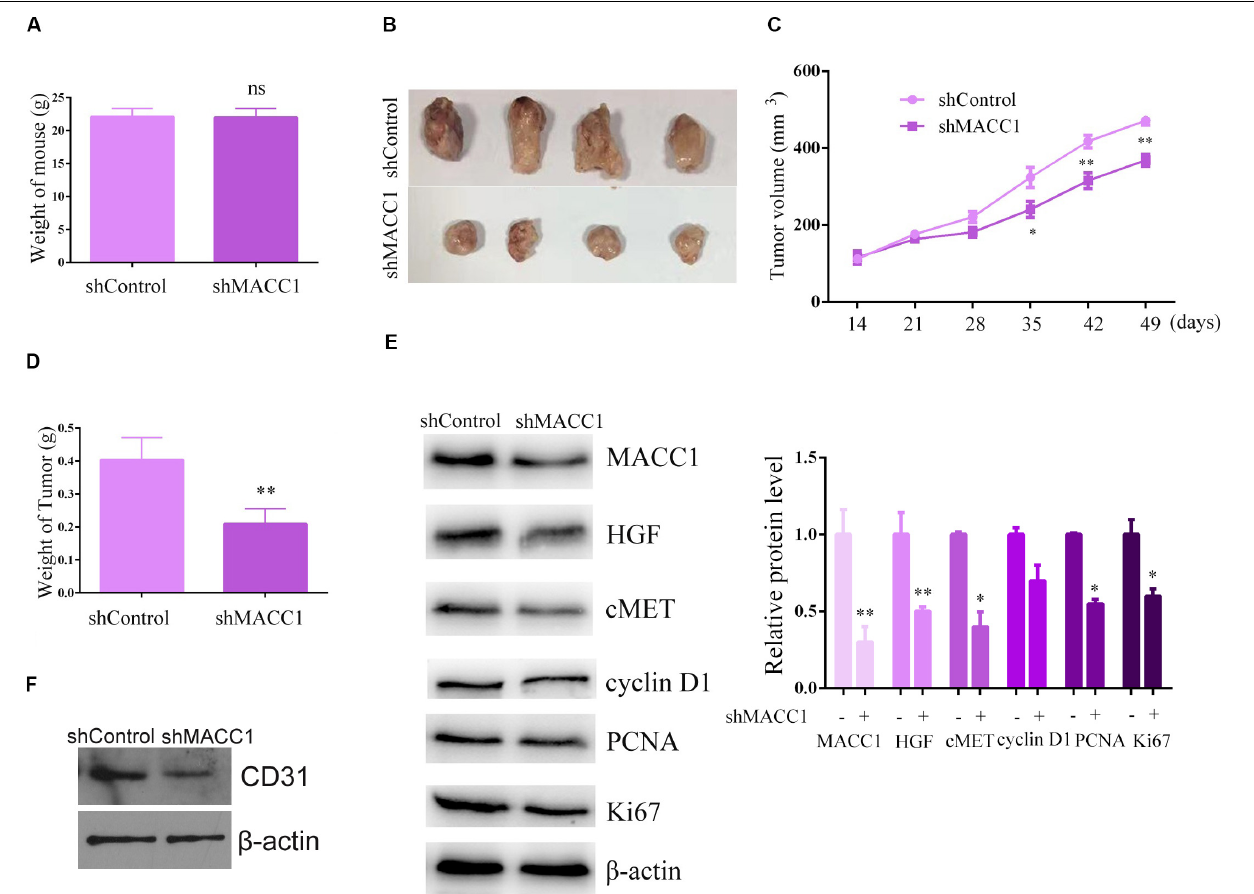
FIGURE 5 | MACC1 depletion inhibits osteosarcoma (OS) cell xenograft tumor growth in mice. U-2OS cells infected with control or MACC1 shRNA lentiviral vectors were subcutaneously implanted into nude mice. After 2 weeks, the tumors were isolated and tumor volume was examined every 7 days ( n = 6 in each group). (A) Mouse weight was compared between control and MACC1 depletion groups. (B) Representative tumor images are shown; a tumor growth curve was calculated and analyzed according to the average volume of 6 tumors in each group. (C) Tumor volume was compared between control and MACC1 depletion groups. (D) Tumor weight was compared between control and MACC1 depletion groups. (E) Immunoblot assays were performed to assess the expression levels of the indicated proteins in control or MACC1-depleted tumor tissues isolated from nude mice. (F) Immunoblot assays were performed to assess the expression levels of the indicated proteins in control or MACC1-depleted tumor tissues isolated from nude mice. Quantification of relative protein level were displayed. Results are presented as means ± SEM; ∗ p < 0.05, ∗∗ p < 0.01, and ∗∗∗ p <